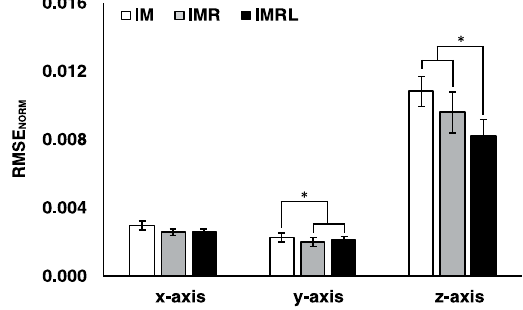
Figure 1. RMSE NORM at the steady-state force production for the x -, y -, and z -axis are presented for the IM (white bars), IMR (gray bars), and IMRL conditions (black bars). Values are means ± standard errors across subjects. The asterisks show significant differences in pairwise comparisons between the conditions ( p <